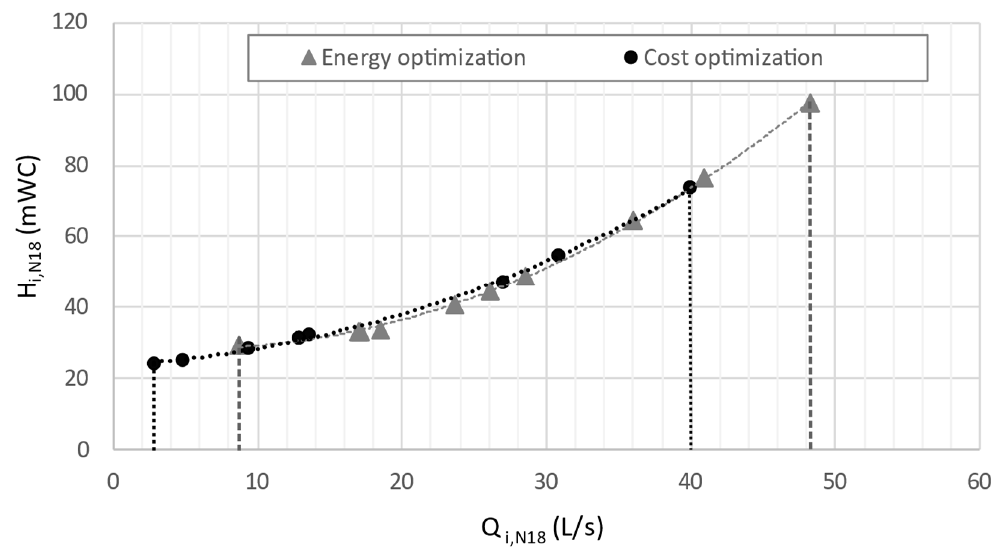
Figure 6. Setpoint curve for pumping station N18.